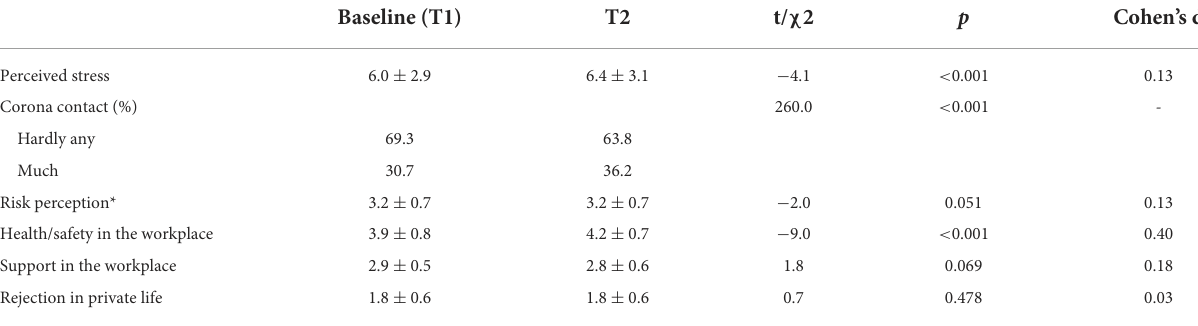
TABLE 4 Change in stress, coronavirus-related risks, and workplace factors of HCWs in cohort T1 + T2 ( n =